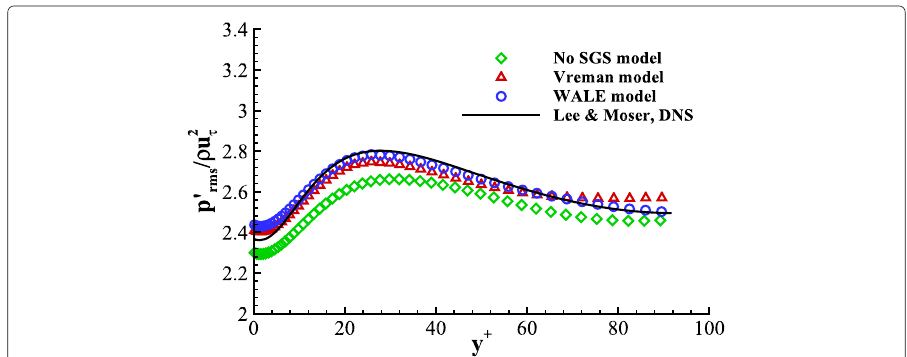
Fig. 12 The r.m.s. pressure fluctuations for the turbulent plane Couette flow at Re τ = 93